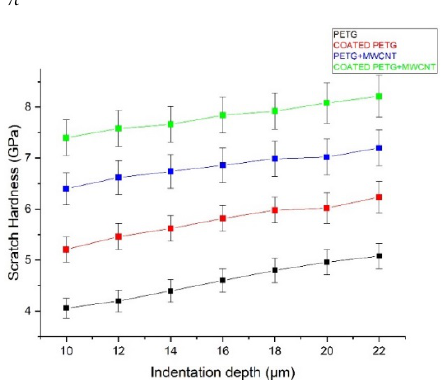
Figure 17. Scratch hardness vs. indentation depth.